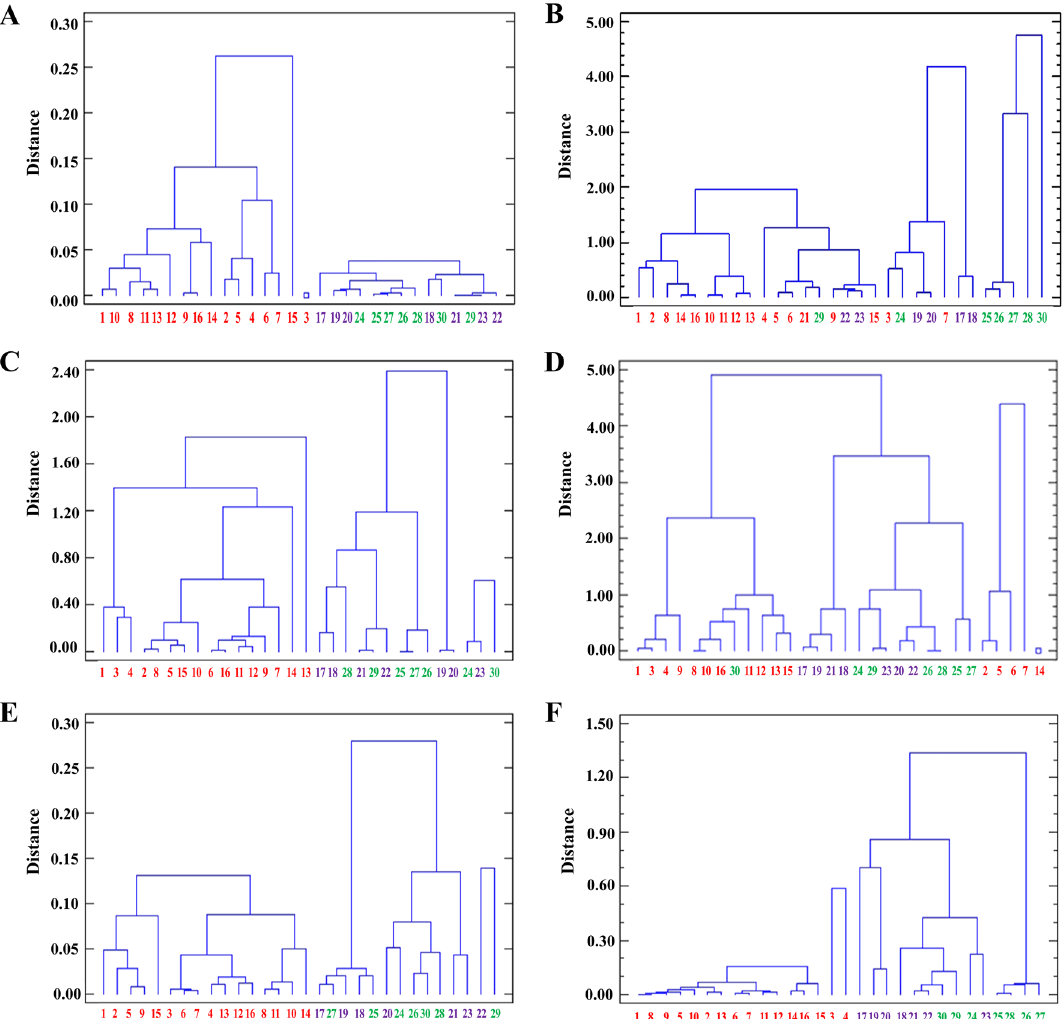
Figure 3. Dendrogram of normal (1–16), opaque-2 (17–23), QPM (24–30) lines based on prolamin ( A ), prolamine-like ( B ), albumin ( C ), globulin ( D ), glutelin-like ( E ) and glutelin fractions ( F ). Dendrogram analysis on group average, squared euclidean basis. For numbering of normal, opaque-2 and QPM genotypes, refer Supplementary Table from 8.04% (HKI 323) to 9.04% (HKI 1128) with 1.12 fold difference, whereas in QPM it ranges from 6.94% (HKI 1105) to 8.83% (VQL 2) with 1.26 fold difference (Supplementary Table S2). Maximum variability was observed within the normal background, whereas opaque-2 and QPM do not exhibit much variability in the accumulation of albumin and globulin content, which indicates that albumin and globulin are least affected by opaque-2 mutation and endosperm modifiers. Glutelin-like content ranges from 9.95% (LM 12) to 12.43% (CML 334) (1.24 fold difference) in normal lines, from 20.34% (DQL 1005) to 23.51% (HKI 323) (1.5 fold difference) in opaque-2 and from 19.93% (LM 11 236B) to 24.66% (VQL 2) (1.24 fold difference) in QPM genotypes. Genetic variation was again found to influence the glutelin content as significant variation has been observed among normal {11.12% (CML 266) to 19.65% (HKI 323 N) (1.81 fold difference)}, opaque-2 {29.45% (HKI 1128) to 36.65% (CML 269) (1.24 fold difference)} and QPM lines {31.13% (VQL 2) to 34.43% (LM11 288) (1.11 fold difference)} (Supplementary Table S1). For glutelin and glutelin-like protein contents, maximum variability was observed within opaque-2 germplasm as compared to normal and QPM counterparts. From the present results, it is inferred that opaque-2 mutation leads to vari- able increases in glutelin fractions as a compensatory mechanism to cope up decrease in prolamin fractions. Protein marker for quality assurance and QPM development. Maize is increasingly being used for human consumption, so QPM has many potential health and nutrition benefits, and can be utilized as a com- mercial nutritious product. However, a mechanism is needed, whereby the normal maize can be differentiated from QPM, so that the industry can develop value chains for procurement and stocking of QPM. It is observed that among different protein fractions, albumin, prolamin, glutelin and glutelin-like fractions can differentiate normal maize from high protein-quality maize, i.e. opaque-2 and QPM lines (Fig. 3A,C,E,F). In normal maize,